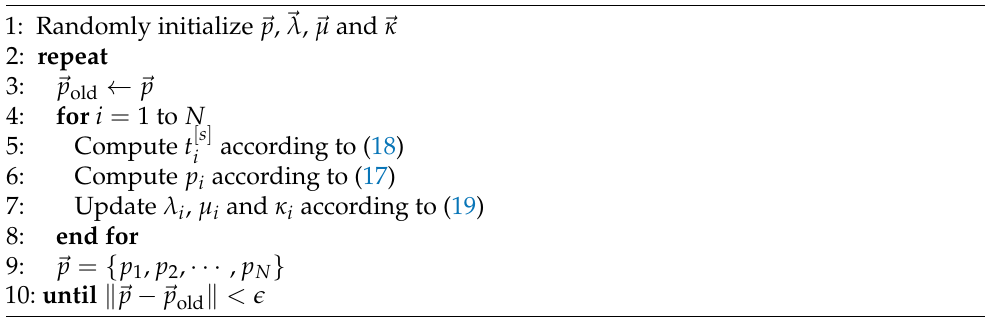
Algorithm 1 Low-complexity transmit power control